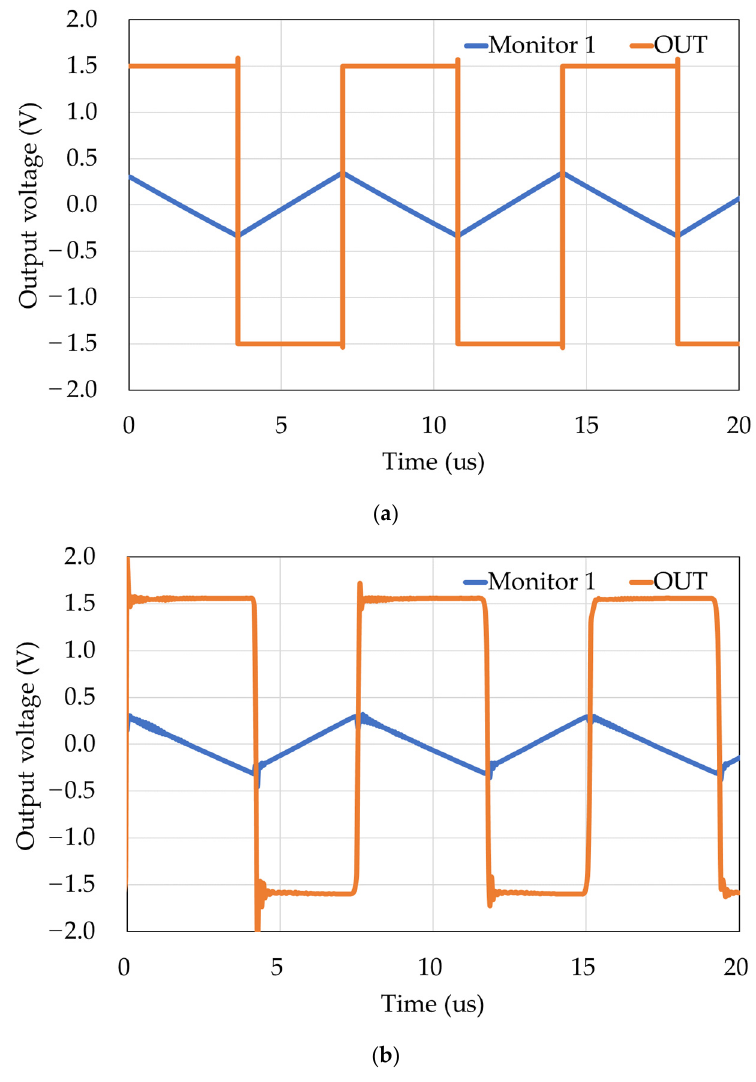
Figure 9. Output waveforms. ( a ) Simulation. ( b ) Actual measurements.